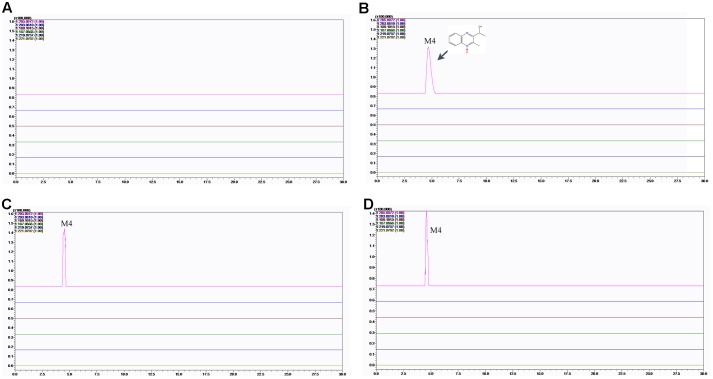
Accurate EIC of MEQ and metabolites of MEQ in the testes of male mice. (A) Testis of the control. (B) Testis from the 25 mg/kg MEQ group. (C) Testis from the 55 mg/kg MEQ group. (D) Testis from the 110 mg/kg MEQ group.